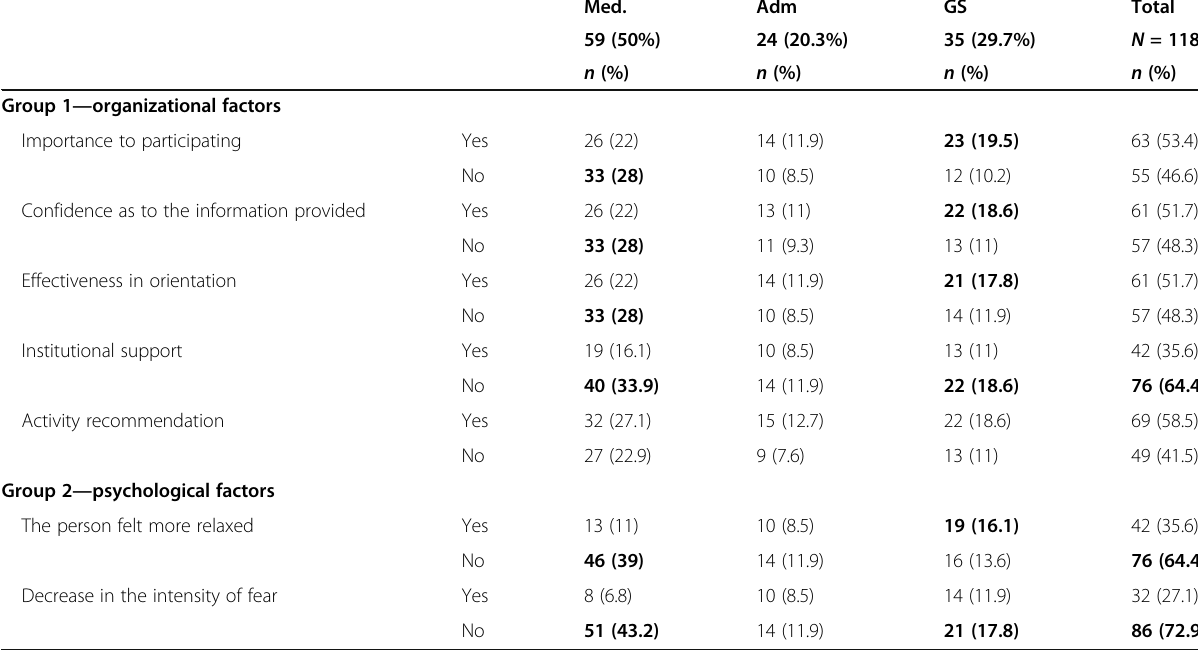
Table 4 Evaluation of the program by the 118 professionals — post-care